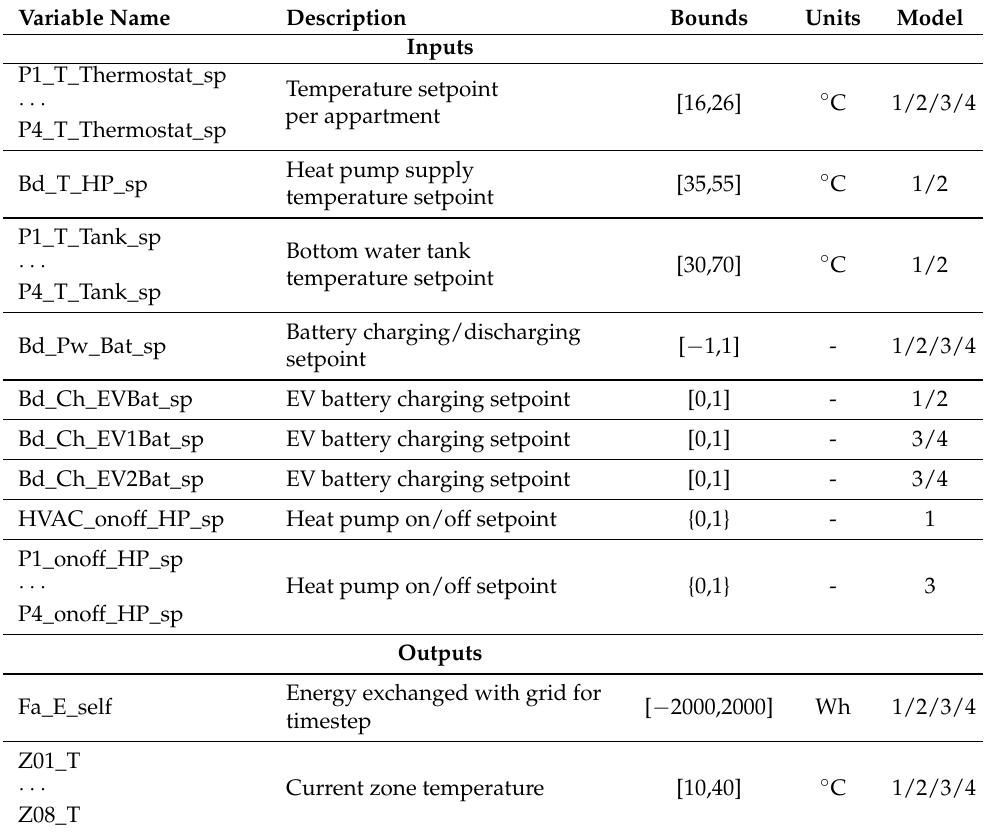
Table A2. Inputs and outputs for the models ApartmentsThermal-v0 (1), ApartmentsGrid-v0 (2), Apartments2Thermal-v0 (3) and Apartments2Grid-v0 (4).